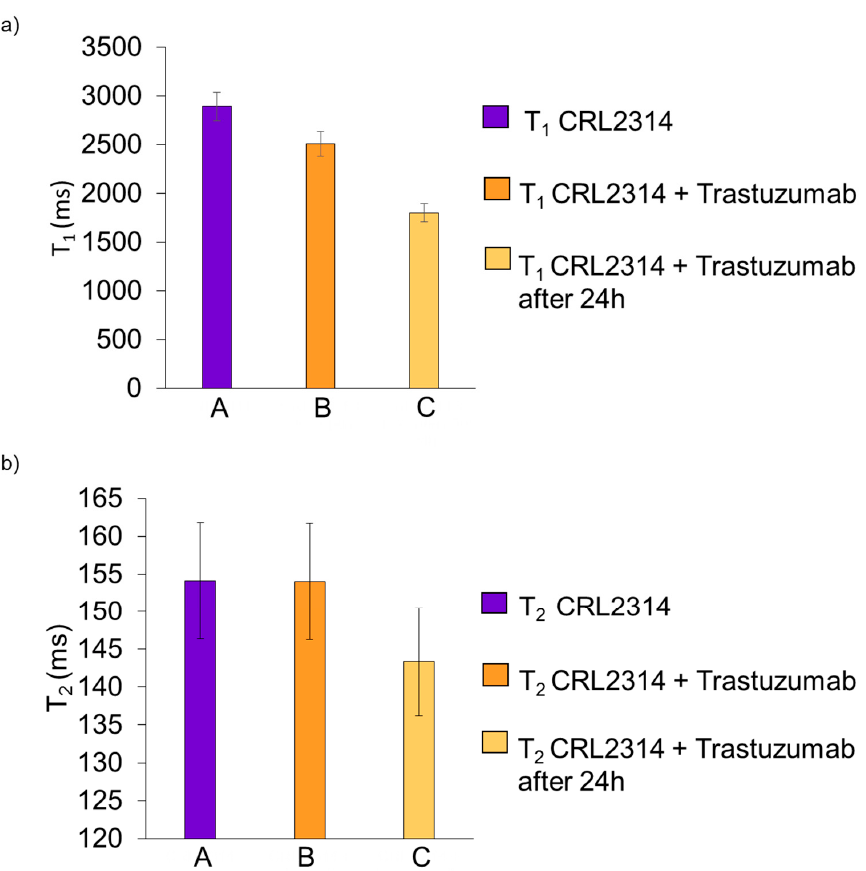
Figure 10. Results of T 1 ( a ) and T 2 ( b ) relaxation times for CRL-2314 cell culture in a 3D bioreactor (A), and the same culture with the addition of Trastuzumab (B), along with the results after 24 h (C).